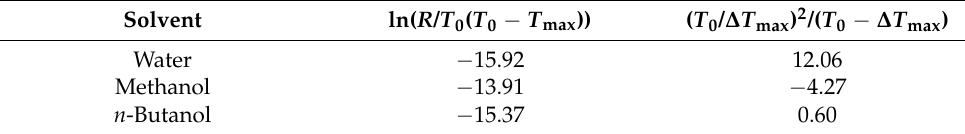
Table 4. Adipic acid intersects at a certain point at different temperatures.